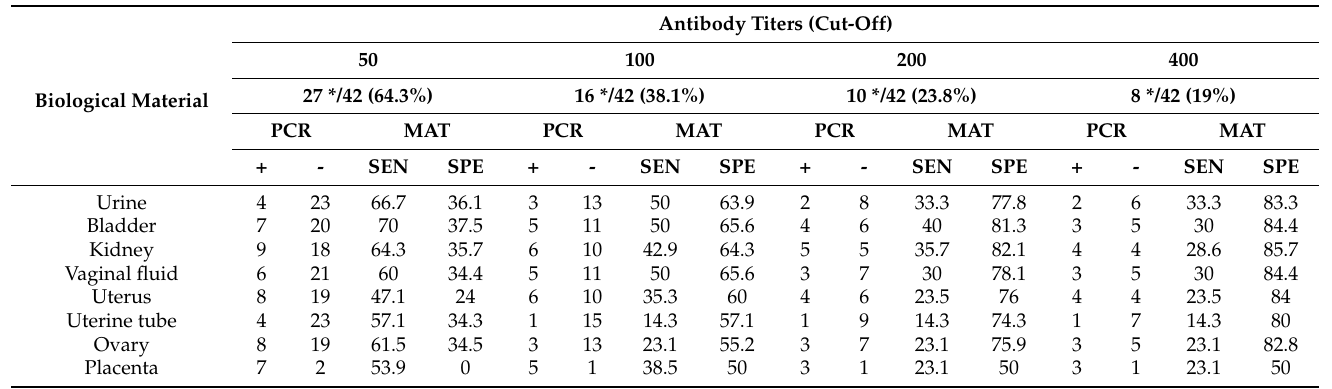
Table 4. Performance of different MAT cut-offs using molecular analysis (PCR) as gold standard per biological material.